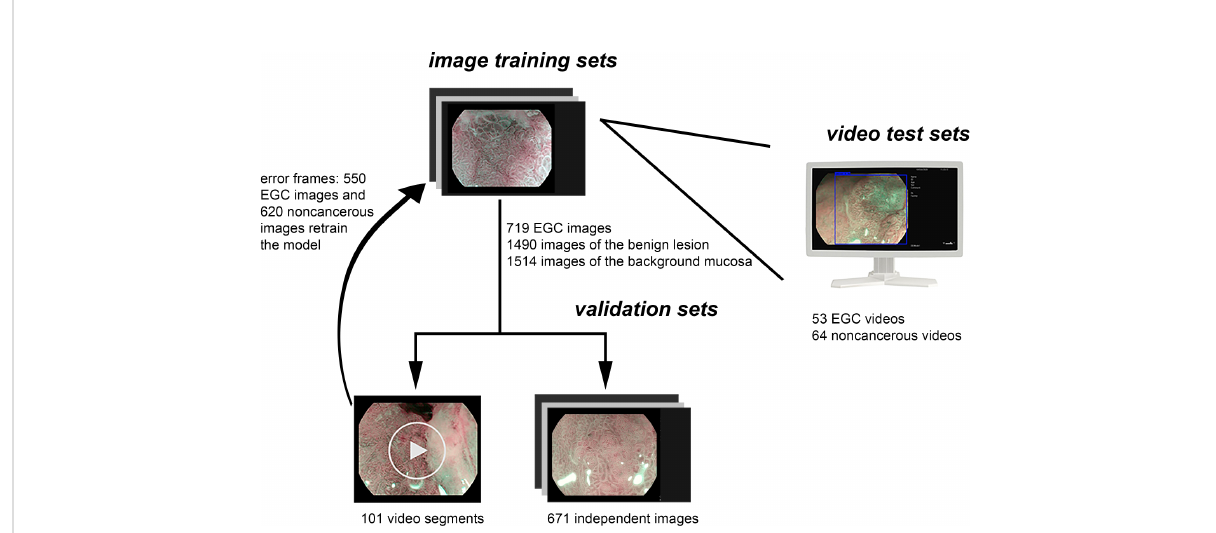
FIGURE 1 Data fl ow chart of the computer-aided system. Firstly, the model was developed using the training sets. Secondly, the model was evaluated by independent validation sets including videos and images, and the video frames with error were labeled and retrained the model. Finally, the model was tested using independent test video sets.